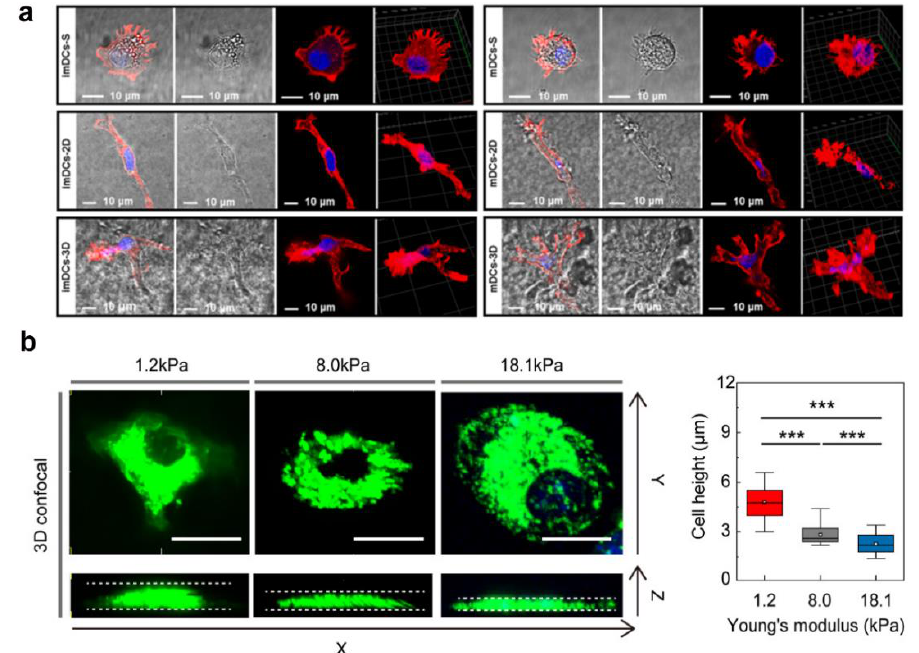
Figure 15. Matrix dimensionality and stiffness regulate DC morphology. ( a ) Representative confocal images of the cytoskeletons of DCs cultured on 2D and in 3D fibrin hydrogels (reprinted/adapted with permission from Ref. [13], 2022, Hu et al.). ( b ) Morphological changes in DCs cultured in confining agarose hydrogels with different stiffnesses (*** significance level of p < 0.005) (reprinted/adapted with permission from Ref. [11], 2021, Choi et al.).